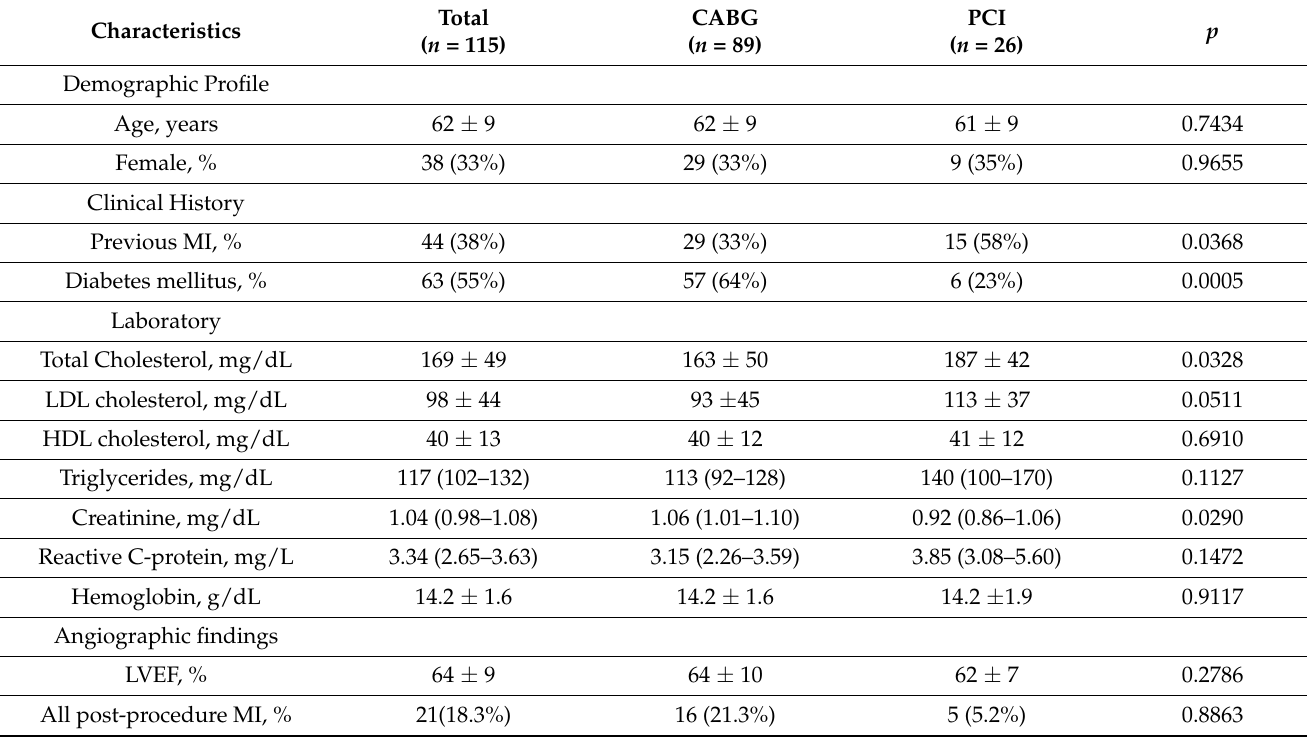
Table 2. Patient’s clinical characteristics and biochemical